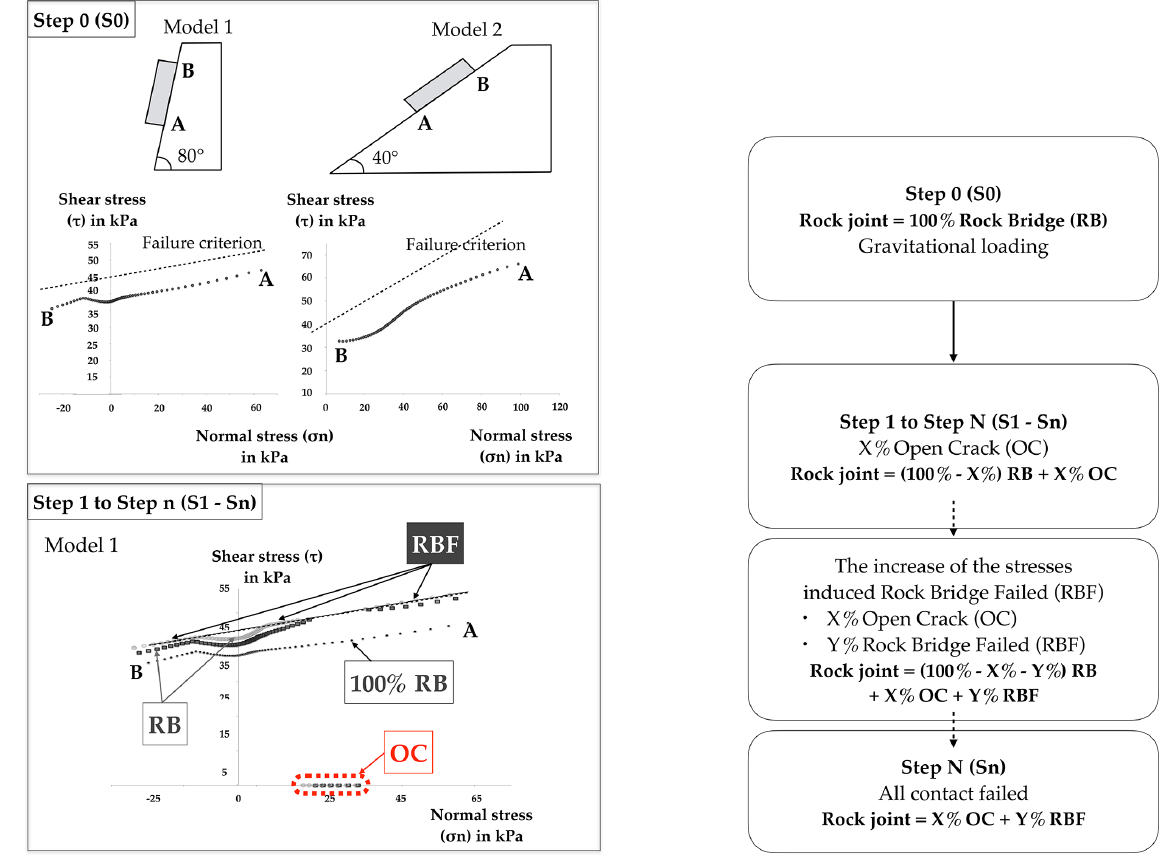
Figure 3. Modelling process. Step 0: 100% of the rock joint is defined as rock bridge (RB). Step 1 to Step n : introduction of open crack (OC) contacts along the joint. From Step 2 to Step n , in the graph of model 1 the increase in shear stresses due to the introduction of OC contacts can be